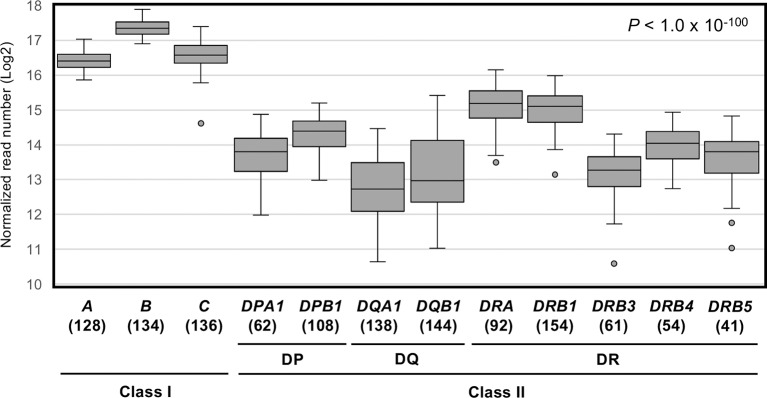
RNA expression levels of 12 human leukocyte antigen (HLA) loci in PBMC samples measured by capture RNA-Seq. These box-and-whisker diagrams were drawn using the dataset 1 obtained from the sequence reads of 78 PBMC samples (Figure S1C). Vertical axis indicates normalized read numbers (Log2) calculated as described in section Material and Methods. Horizontal axis indicates the 12 classical class I and class II HLA loci. Horizontal lines in the boxes indicate median level of expression at each locus. Parenthesis below the locus name indicates the number of individual points plotted per each locus.